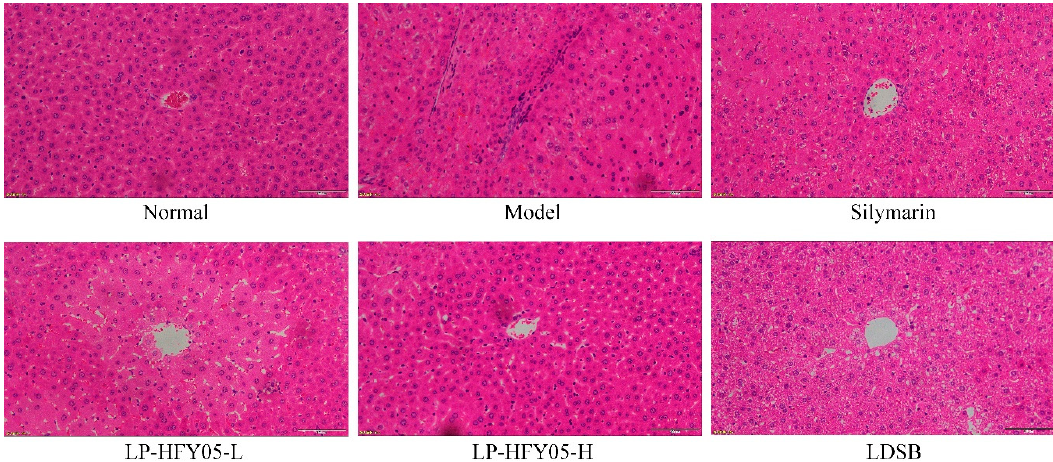
Figure 4. Hematoxylin and eosin pathological observations of hepatic tissues from mice. Magnification 100× (scale bar: 100 μ m). Silymarin: Mice treated with silymarin (100 mg/kg), LP-HFY05-L: Mice treated with a low concentration of Lactobacillus plantarum HFY05 (1.0 × 10 8 CFU/kg), LP-HFY05-H: Mice treated with a high concentration of Lactobacillus plantarum HFY05 (1.0 × 10 9 CFU/kg), LDSB: Mice treated with Lactobacillus delbrueckii subsp. bulgaricus (1.0 × 10 9 CFU/kg).